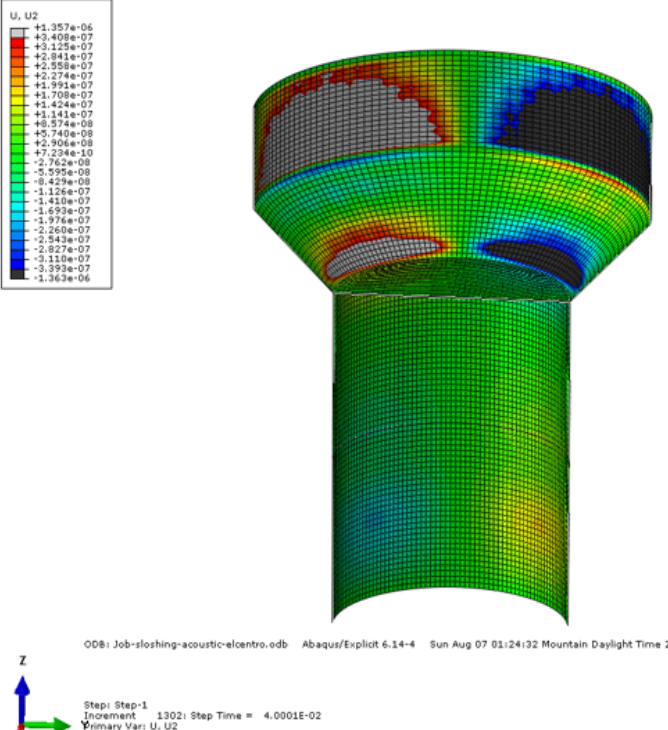
Figure 13. Example of the effect of sloshing on the distribution of maximum deformation for the tank subjected to the El Centro earthquake record .